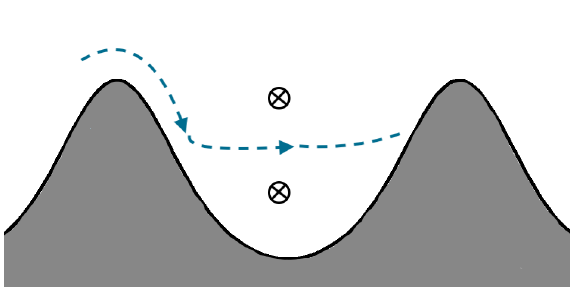
Figure 15. Conceptual model of the formation of the elevated layer of cross-valley flow observed by the wind profiler stationed in the valley center. It is hypothesized that cooler air from the Berneese Oberland crosses the mountain ridge to the north of the Rhone valley (blue dashed arrows), preferentially through lower-lying passes, follows the slopes as a katabatic flow until it reaches its level of neutral buoyancy and flows into the valley center. Below and above the cross-valley flow layer, the flow is in the up-valley direction ( (cid:78) ).